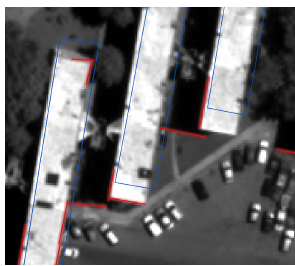
Table 1. Computation time for a 2200x1800 pixels extract of a PHR